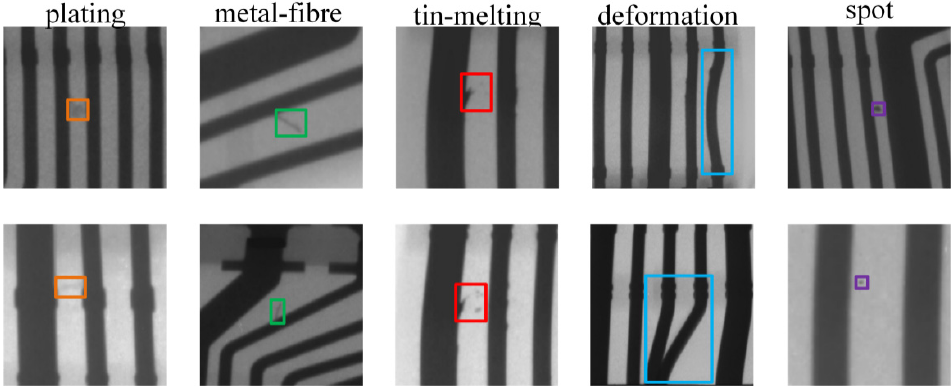
Figure 3. Examples of common types of defects in the insert molding under X-ray.